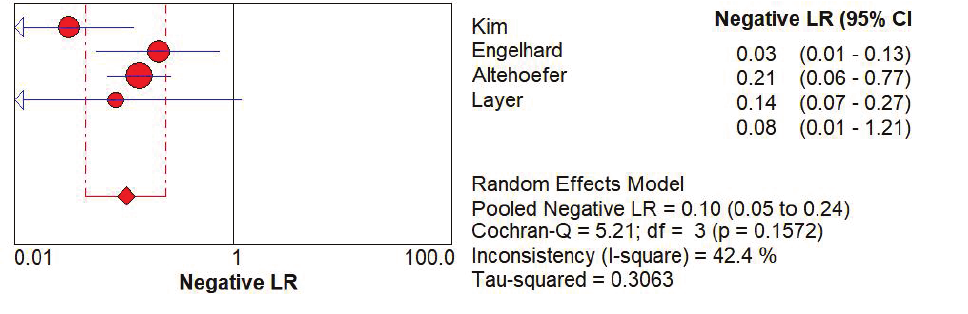
Figure 9: The plot for the specificity of MRI